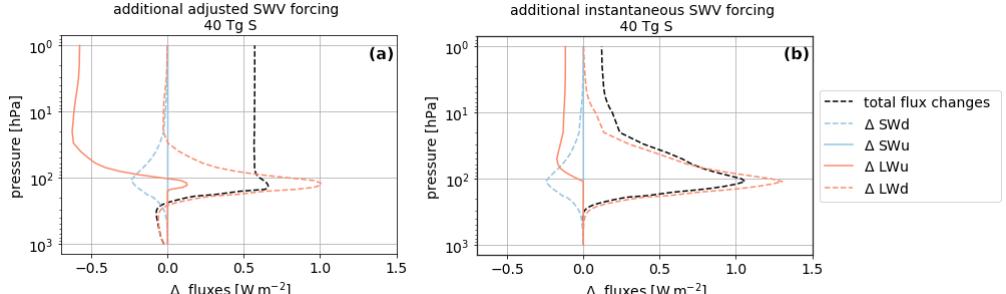
Figure 12. SW and LW contributions to the total adjusted SWV radiative forcing in the tropical stratosphere [− 5 , 5 ] ◦ latitude for Novem- ber 1992 of the 40Tg S eruption. The upward fluxes are in solid lines and positive upward; the downward fluxes are in dashed lines and positive downward. The differences between the perturbed and unperturbed equilibrium states are shown. Panel (a) indicates adjusted forcing and (b) indicates instantaneous forcing.